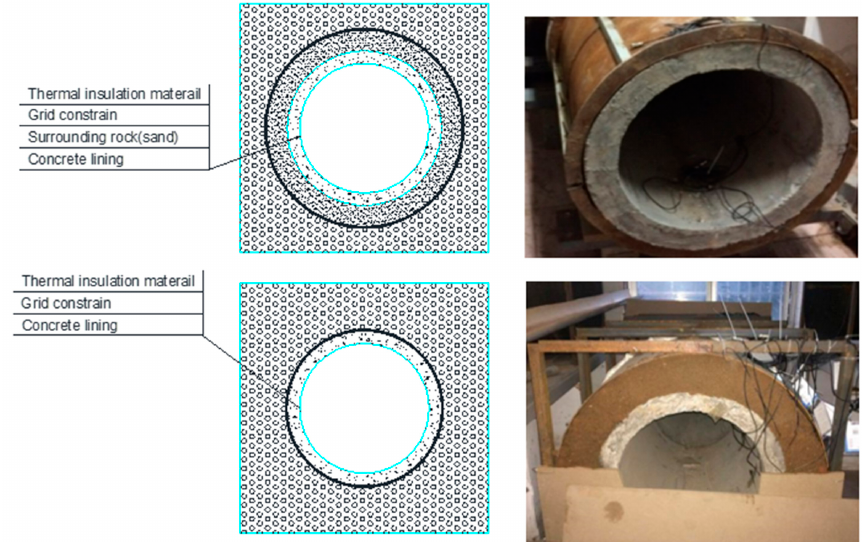
Figure 7. Constraint conditions of the lining of the simulation experiment.